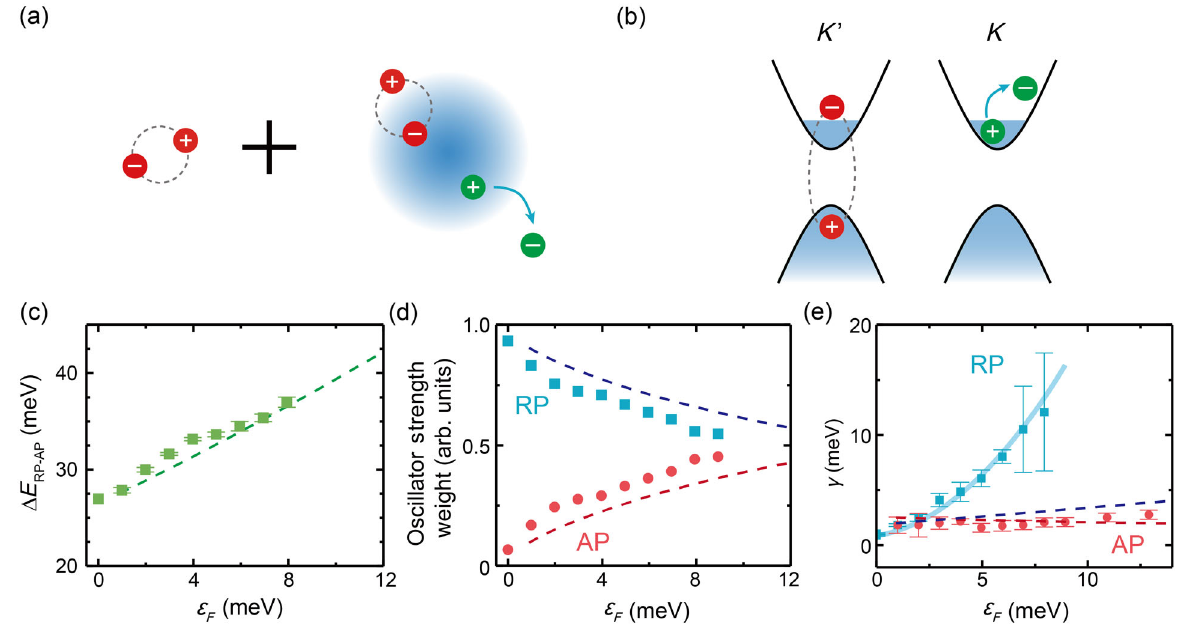
FIG. 4. Polaron theory and comparison with experiments. (a) The exciton polaron is the coherent superposition of a bare exciton and an exciton dressed by a polaron cloud approximated by a single Fermi sea (FS) unbound electron-hole pair in momentum space. (b) Exciton and the FS pair are assumed to reside in different valleys. In panels (a) and (b), red spheres refer to electrons ( − ) and holes ( þ ) in one valley, while green spheres indicate those in the opposite valley. Comparisons between measurements and calculations for (c) energy splitting between APs and RPs, (d) relative oscillator strengths, and (e) homogeneous linewidths of APs and RPs as a function of the Fermi level. In panels (c) – (e), the dashed lines indicate calculations, while solid points are extracted from 2D